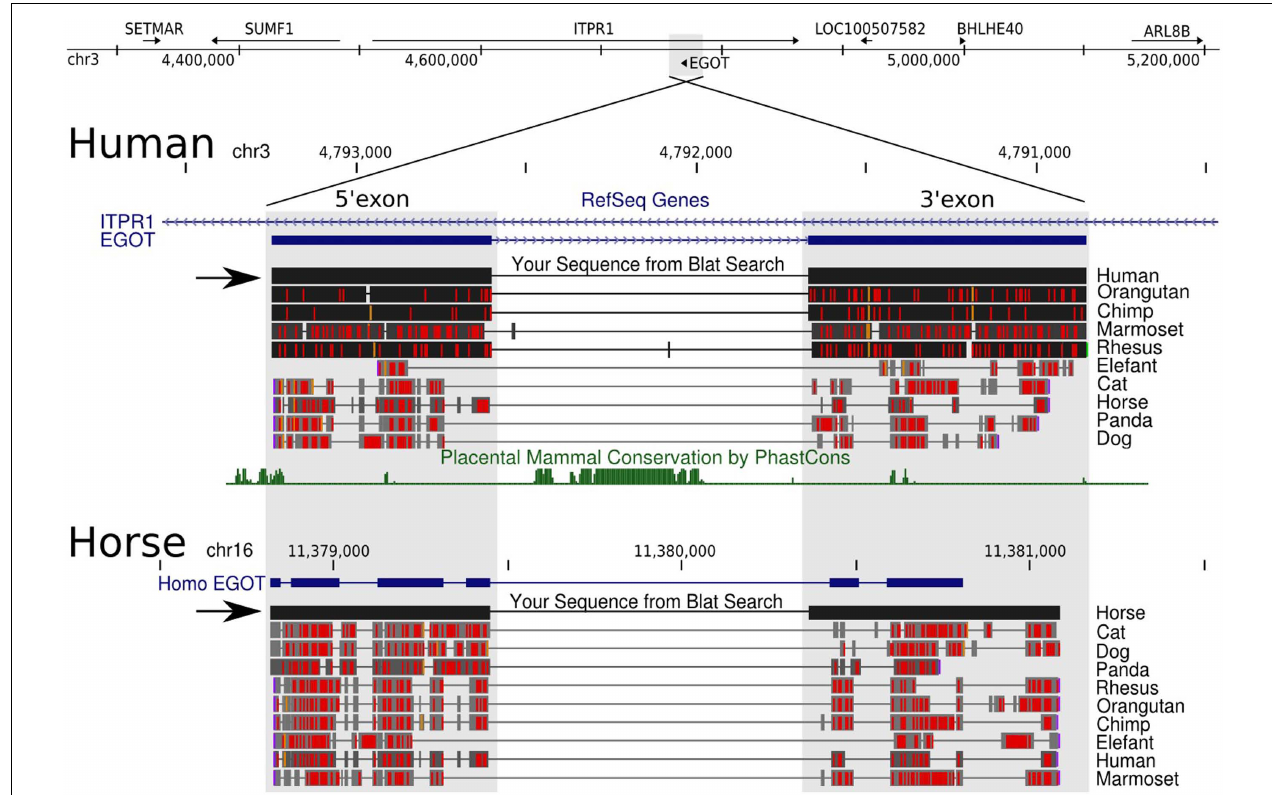
case of horse, for example, even the RefSeq track insufficiently lists only the partial gene structure. Next, sequence conservation, or actually the probability of the EGO-B locus to be under negative selection, is close to zero according to the phastCons program. Nevertheless, we were able to compile a set of at least 25 strong candidates of EGO-B orthologs.